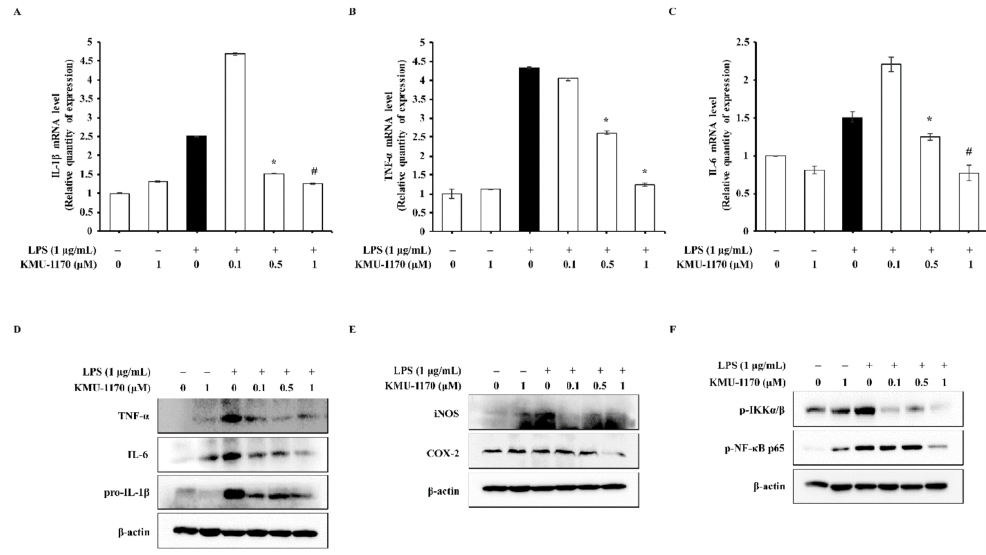
Figure 6. Inhibitory effect of KMU-1170 on LPS-mediated inflammatory response in primary human osteoarthritic FLS. Cells were treated with LPS (1 µ g/mL) for 6 h after pretreatment with different doses of KMU-1170 (0.1, 0.5, and 1 µ M) for 1 h. ( A – C ) Total RNA was extracted and used to determine the mRNA expression levels of IL-1 β , TNF- α , and IL-6 using real time PCR. ( D ) Whole cell lysates were isolated and used to measure the protein expression levels of pro-IL-1 β , TNF- α , IL-6, and β -actin by Western blot analysis. ( E ) Whole cell lysates were isolated and used to measure the protein expression levels of iNOS, COX-2, and β -actin by Western blot analysis. ( F ) Whole cell lysates were isolated and used to measure the protein expression levels of p-IKK α / β , p-NF- κ B p65, and β -actin by Western blot analysis. * p < 0.01 and # p < 0.001 compared to LPS